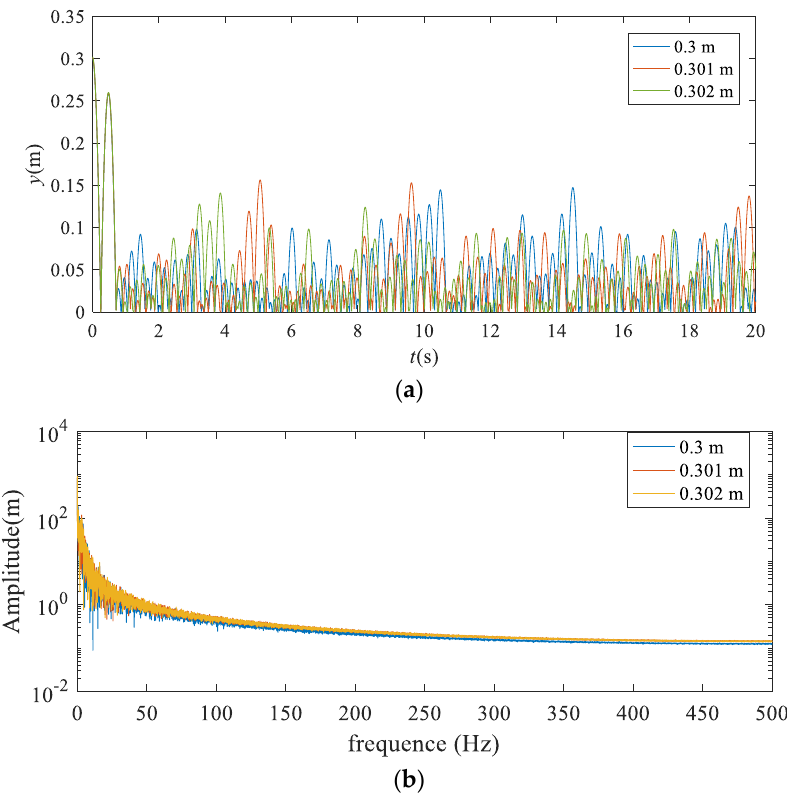
Figure 2. Dynamic response of the particles with different falling heights: ( a ) the trajectories of the particles and ( b ) the frequency spectra of the particles.